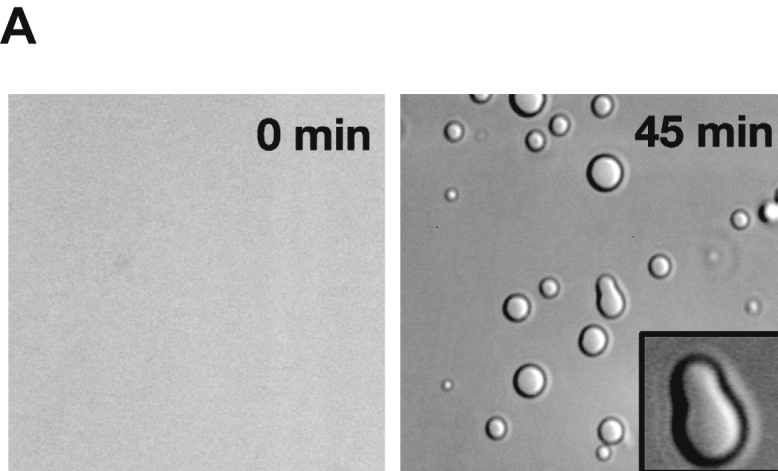
Recombinant ANXA11 Undergoes Liquid-Liquid Phase Separation In Vitro, Related to Figure 2A. Purified ANXA11 protein formed biological condensates.Full-length wild type ANXA11 formed spherical, fusing liquid droplets at ANXA11 concentrations at 10μM facilitated by 10% dextran. Inset shows a fusion event between two phase separated liquid droplets.